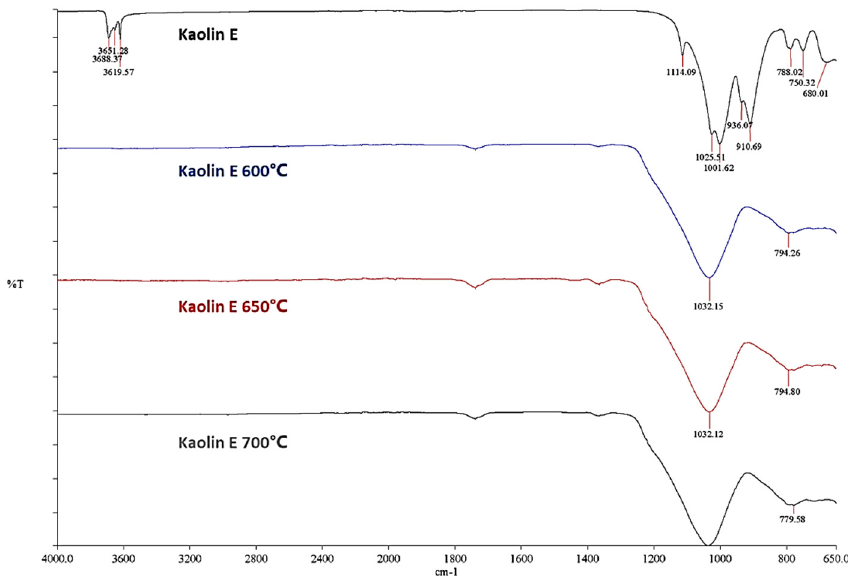
Figure 5. FTIR spectra of Kaolin E and its calcined products at 600, 650 and 700 °C.